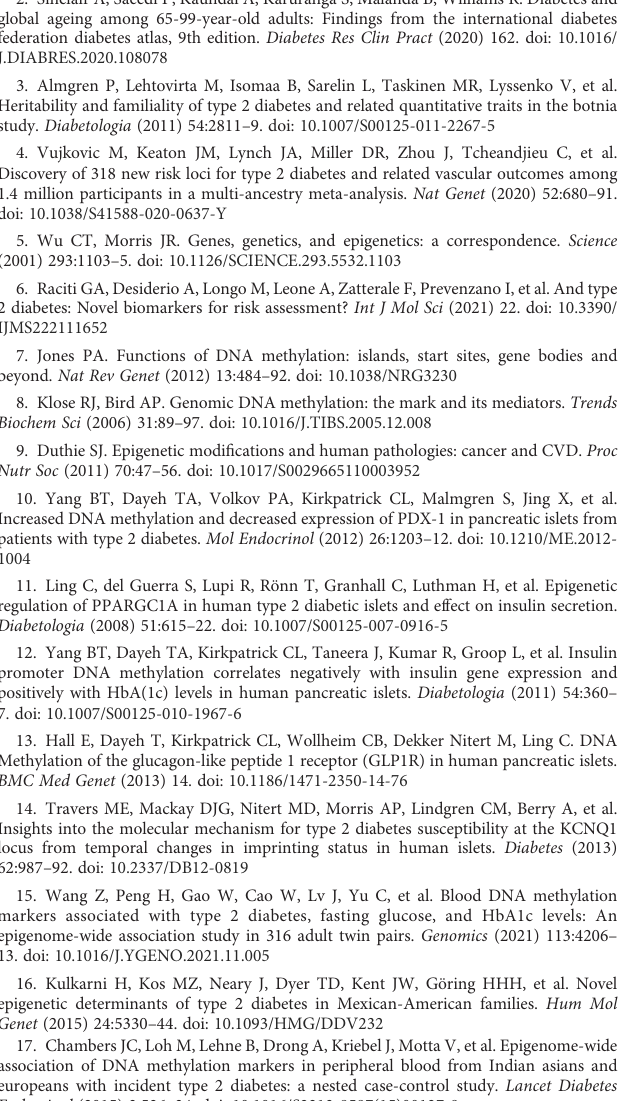
SUPPLEMENTARY FIGURE 3 Distribution of DNA methylation levels in each gene elements. Red, blue and green lines represent CG, CHG and CHH, respectively. H: Han, Z: